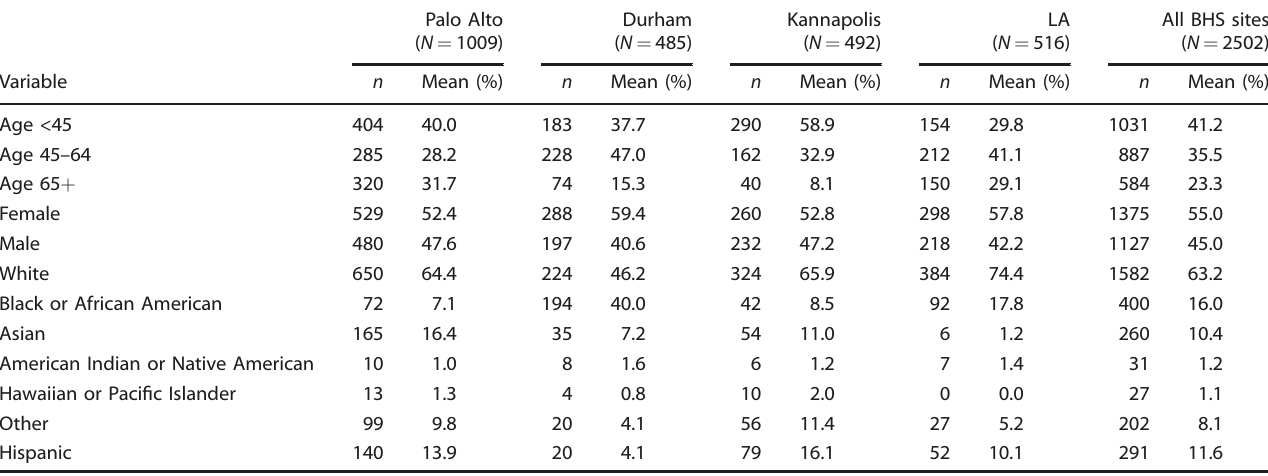
Table 1. Demographics of the initial